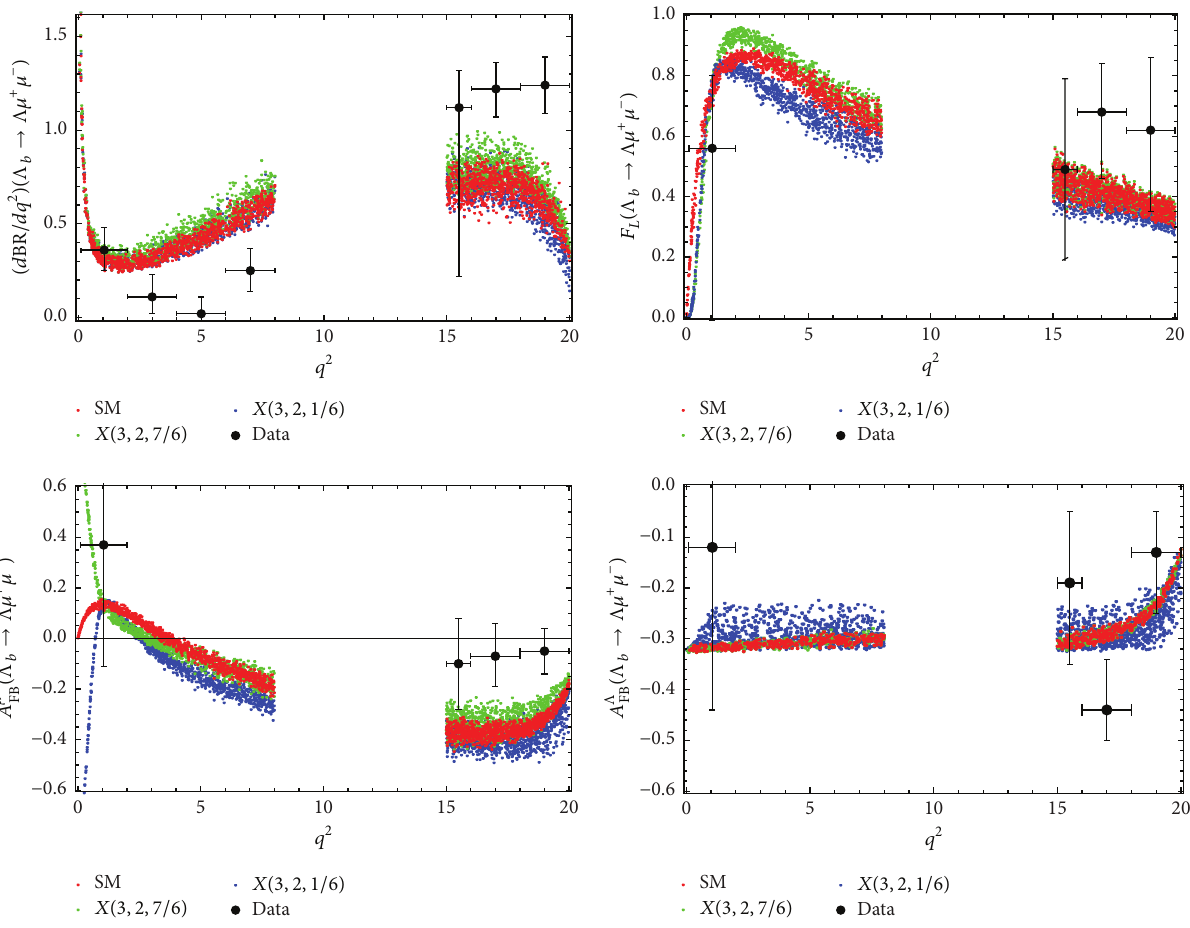
𝜇 𝐴 Λ 𝑞 2 , FB on FB , and